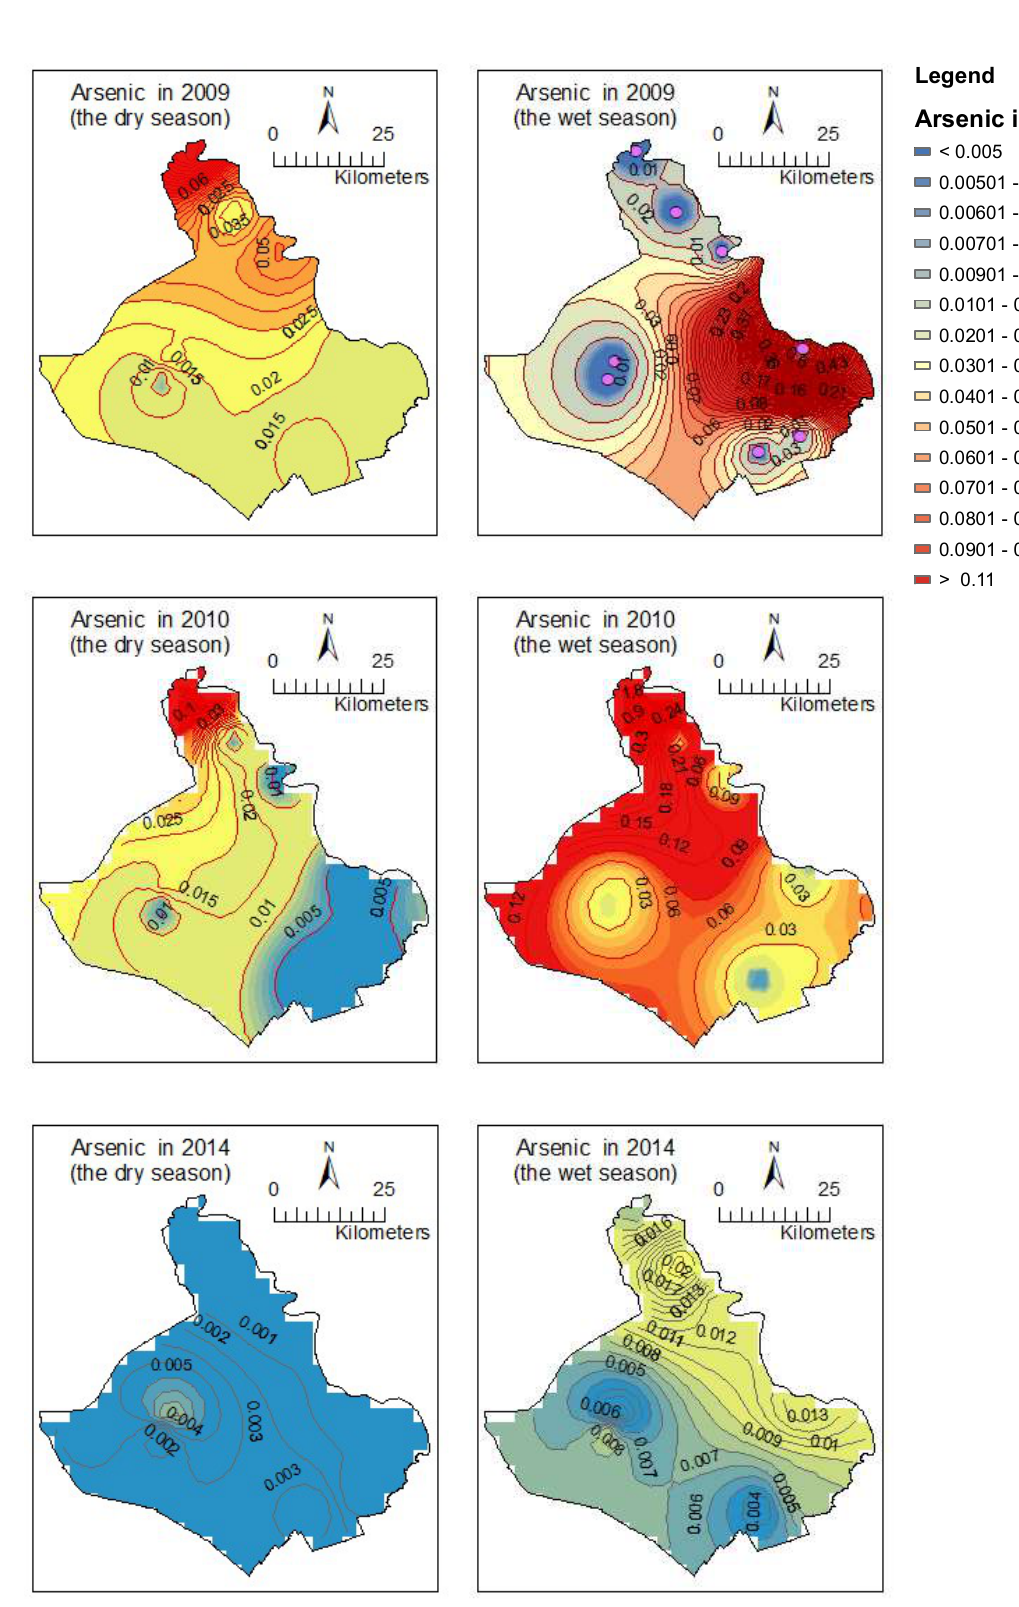
Figure A1. Concentrations of As (mg / L) were displayed by IDW in An Giang province.